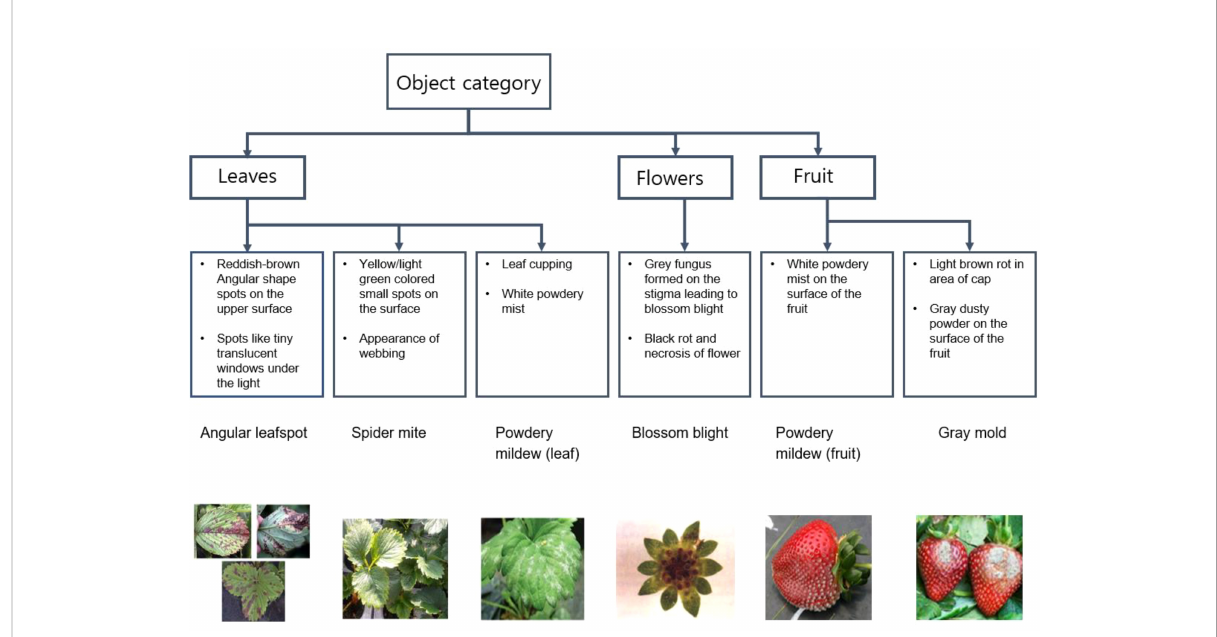
FIGURE 4 Diagnostic strategy from visual symptoms for angular leaf spot, spider mite, powdery mildew, blossom blight and gray mold rot identi fi cation in strawberry